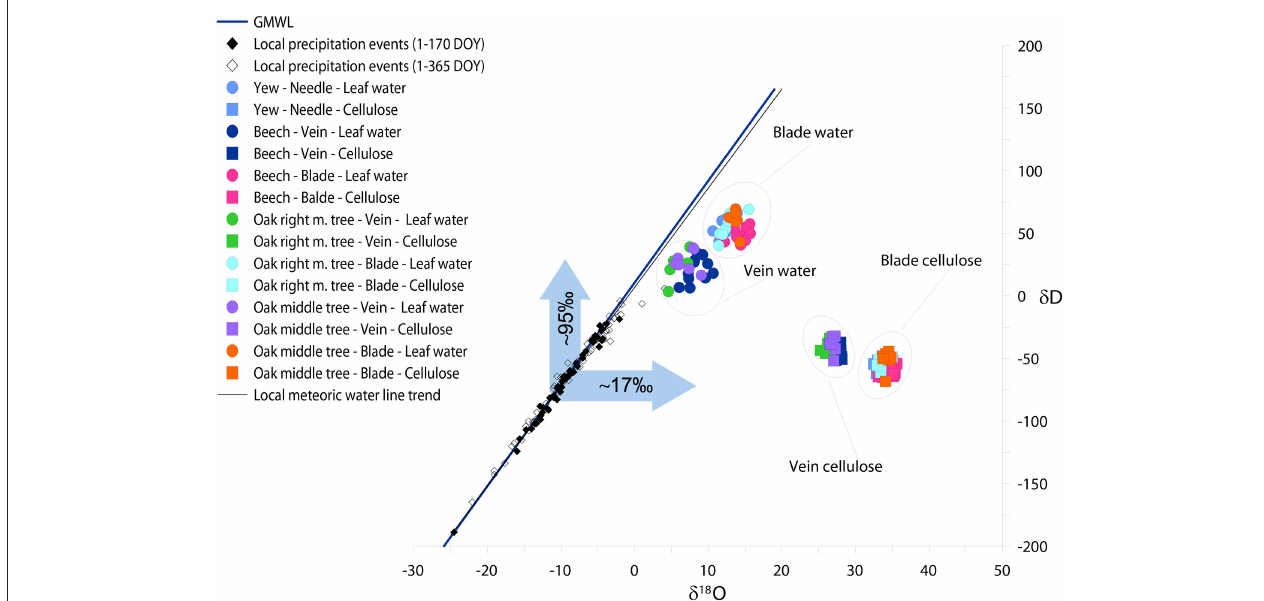
FIGURE 4 | The relationship between δ D and δ 18 O of local precipitation, species specific calculated leaf water, and measured leaf cellulose in mature leaves (DOY 150–365). Different colors denote different trees. Circles, squares, open, and closed diamonds denote the isotopic composition of leaf water, cellulose, precipitation events during 1–365 DOY and precipitation events during 1–170 DOY, respectively. The blue arrows denote the isotopic shift of δ D and δ 18 O of vein leaf water compared to the annual mean δ D and δ 18 O of precipitation. The blue and black lines represent the global and local meteoric water line, respectively.